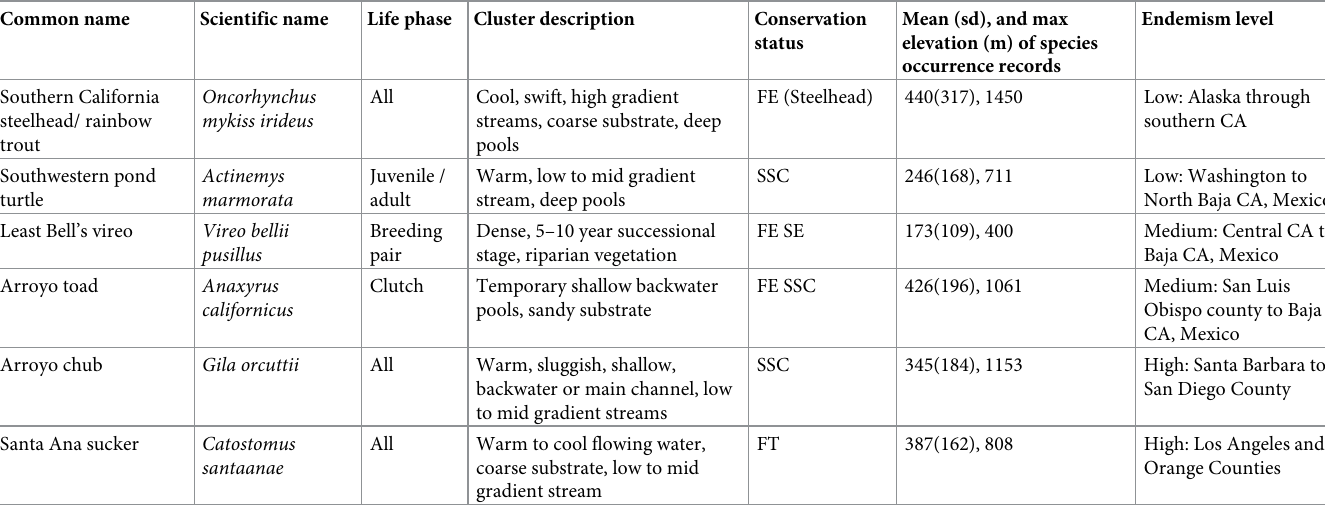
Table 1. Focal species for habitat